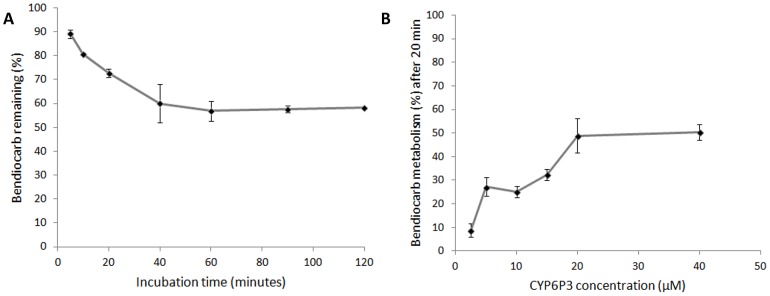

In vitro metabolism of bendiocarb by recombinant CYP6P3 expressed in E. coli.In both plots, which show the effect of (A) incubation time and (B) enzyme concentration, points show the mean of three replicates (following subtraction of no-NADPH negative control values) ± one standard error.